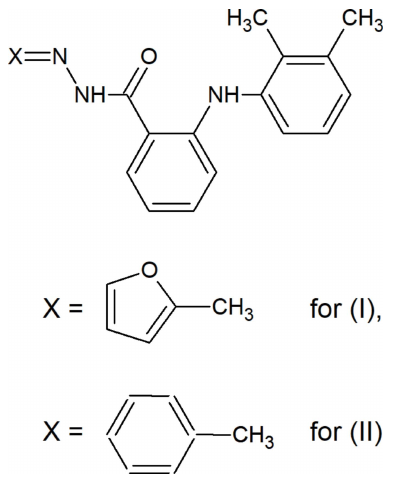
Table 1 Hydrogen-bond geometry (A˚ , (cid:3) ) for (I).